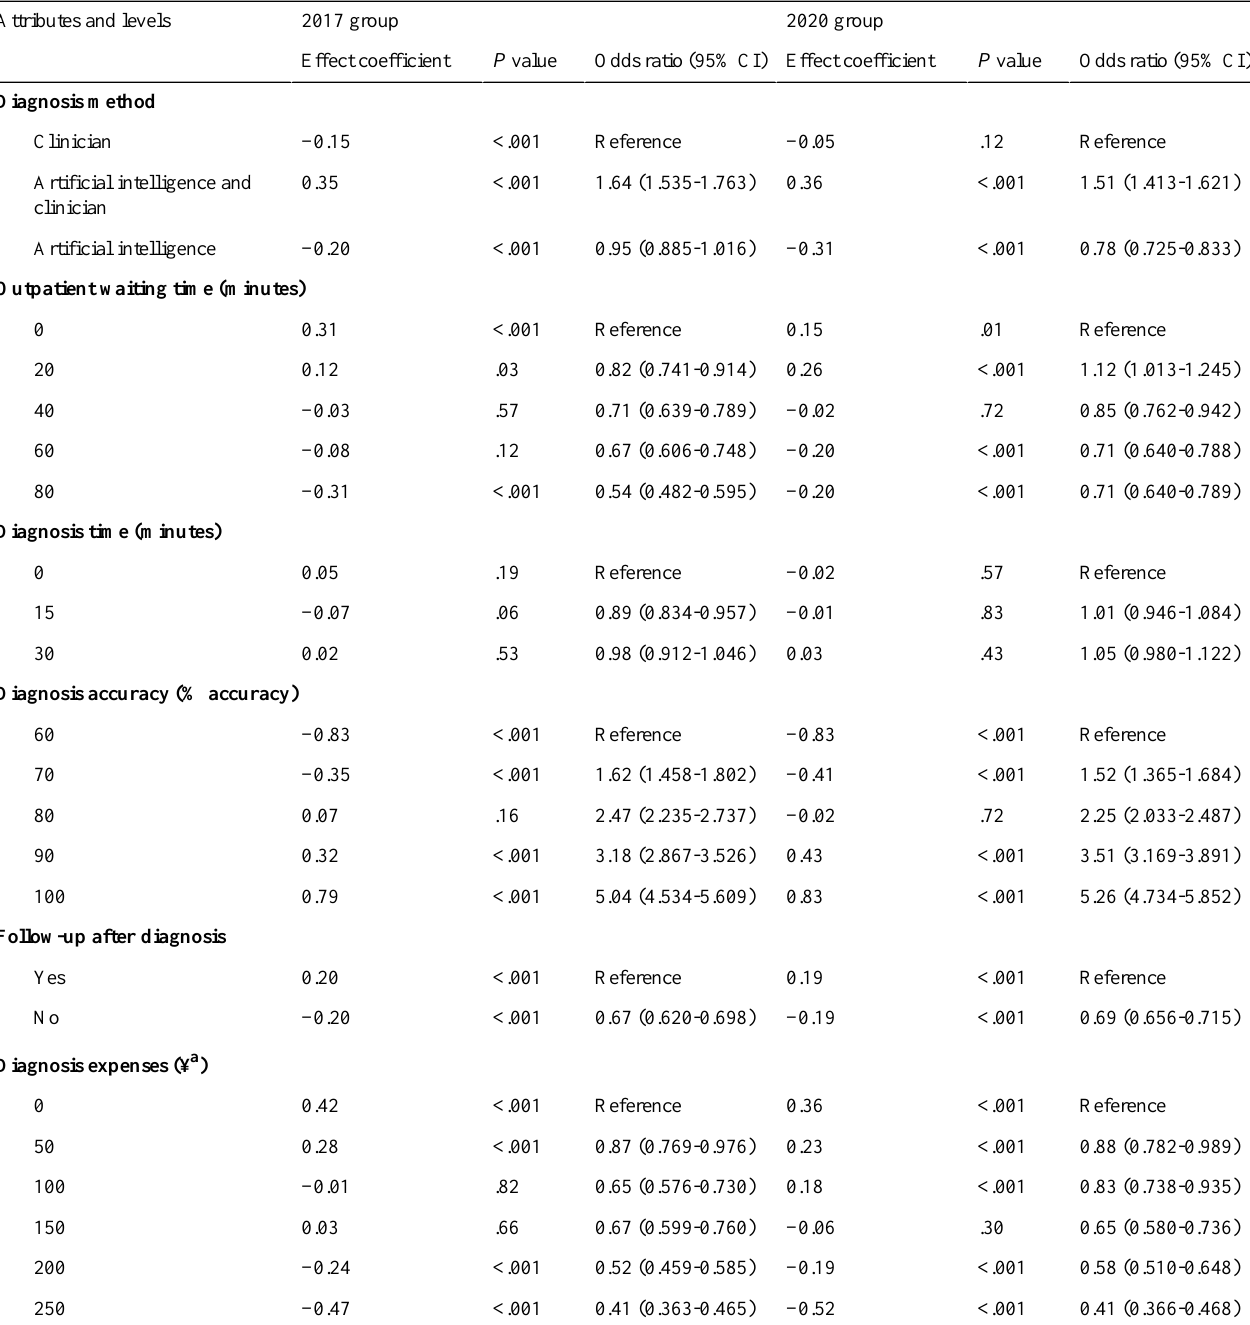
Table 2. General results of the multinomial logit model. Data on propensity score–matched respondents’ preferences for diagnosis attributes in 2017 and 2020 are reported